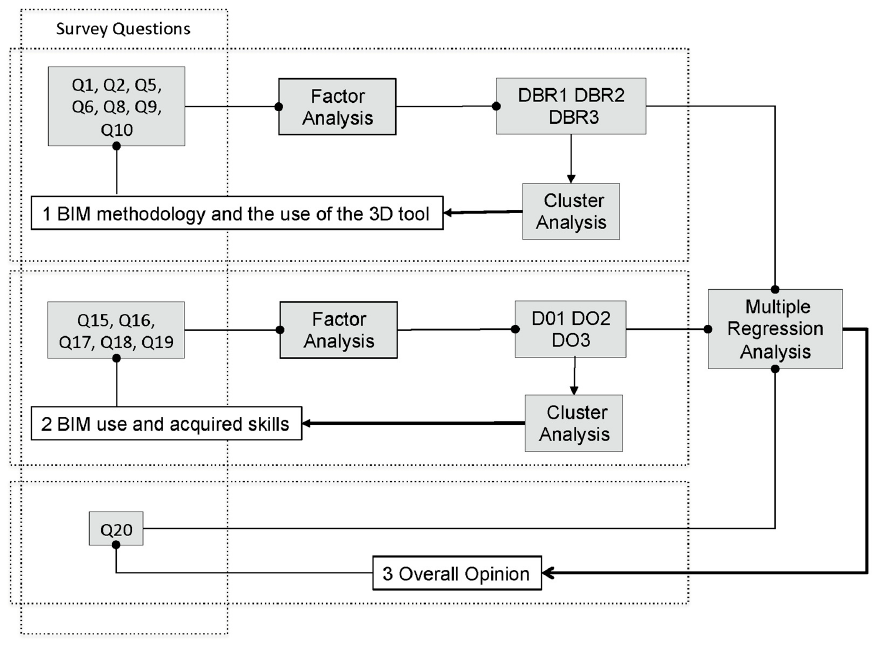
Figure 2. Flow chart of the BIM implementation for a technical project course. Table 1. Questions about the BIM